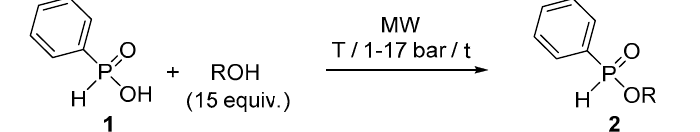
Table 1. Direct esterification of phenyl- H -phosphinic acid ( 1 ) in a batch MW reactor.